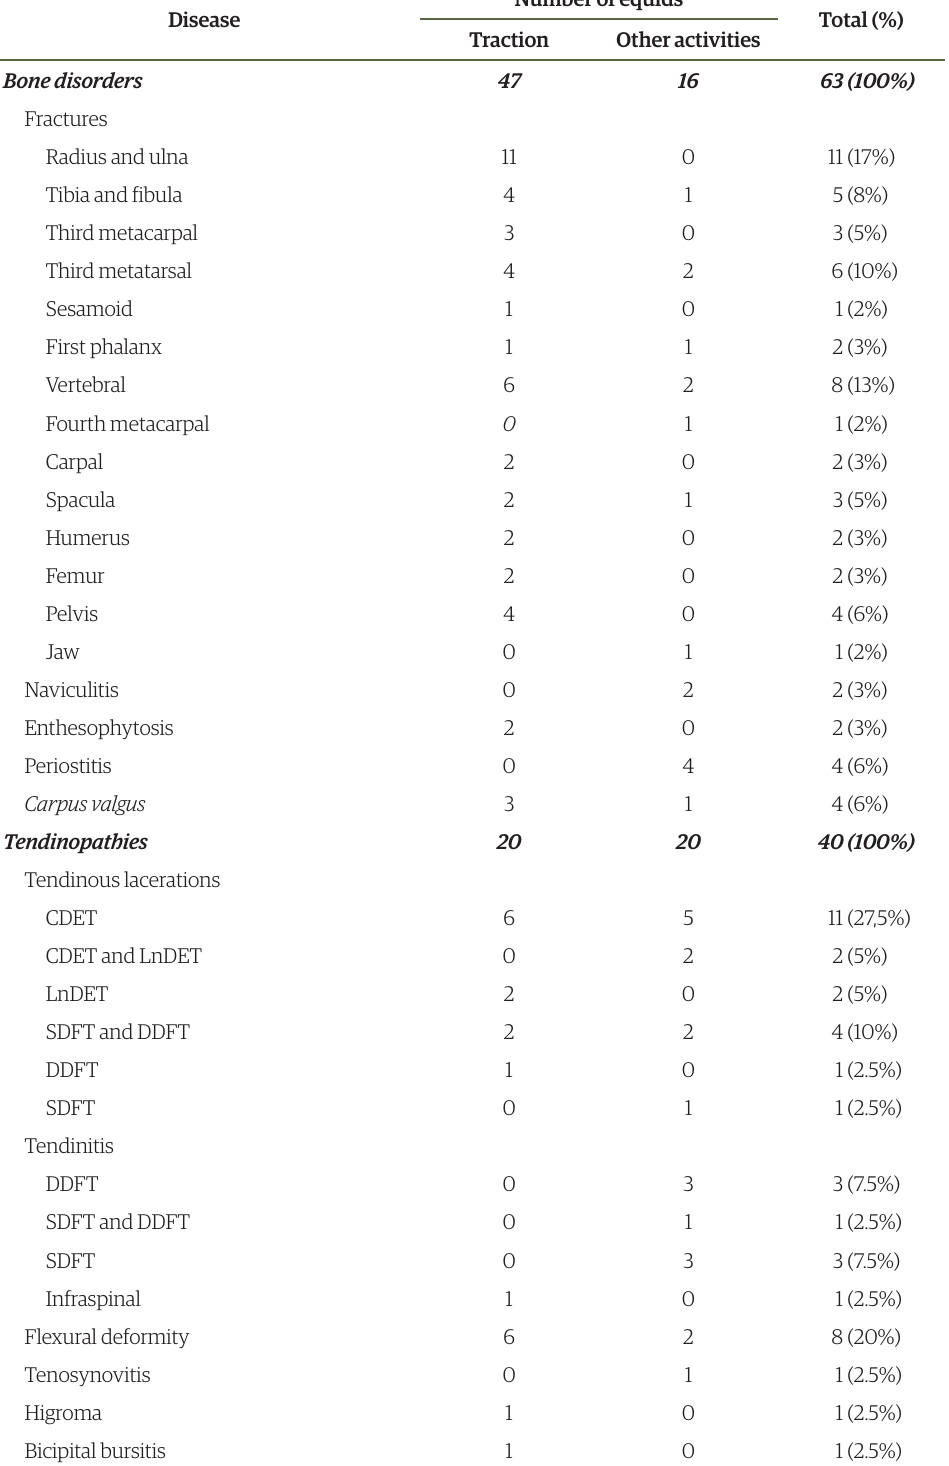
table 1. Prevalence of the main orthopedic diseases in 156 equids attended at the Large Animal Veterinary Teaching Hospital of Universidade de Brasília, from March 2016 to February